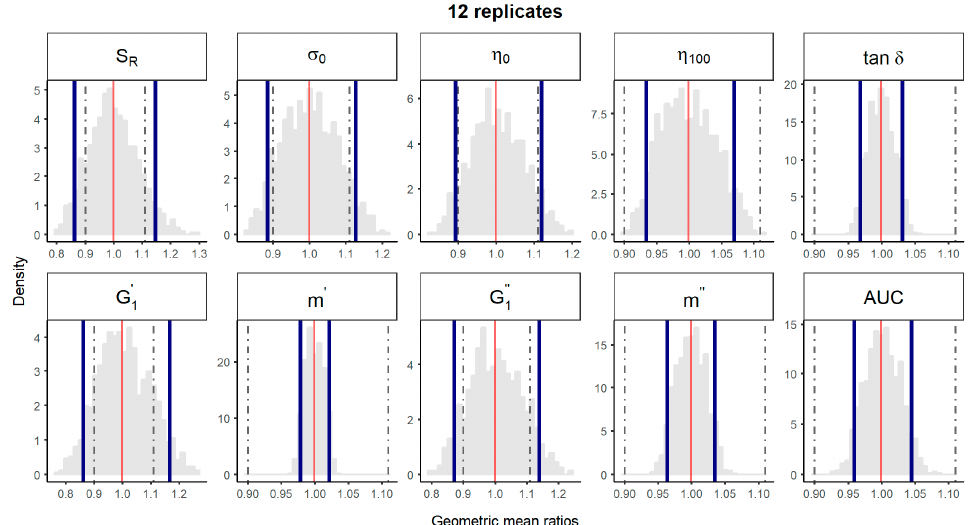
Figure 3. Bootstrap analysis of rheological parameters – five reference batches versus five reference batches. 10,000 geometric mean ratios (light grey area) resulting from the bootstrap analysis of “5 reference batches versus five test batches” for each rheological parameter. Data of 10 batches and 12 replicate each were used. Median (solid red line) and non-parametric 90% CI (solid blue lines) of the probability distribution. Dashed lines represent the acceptance limits for equivalence (90–111.11%) stated in the EMA guideline [4]. S R , relative thixotropic area; σ 0 , yield stress; η 0 , zero-shear viscosity; η 100 , viscosity at 100 s − 1 ; tan δ , loss tangent at 1 Hz; G (cid:48) , calculated elastic modulus; G (cid:48)(cid:48) , calculated viscous modulus; m’ and m ” are the parameters obtained when fitting G’ and G”, respectively, versus frequency; AUC, area under the surface versus weight curve (spreadability).